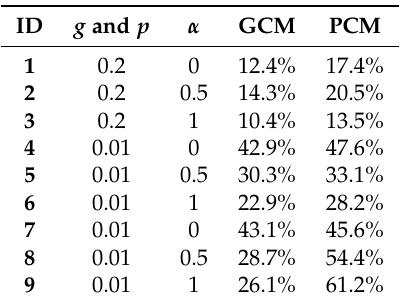
Table 1. Simulation experiments. Legend: ID is the experiment identifier; g , p refer to the cell coverage thresholds; GCM is the global coverage metric; PCM is the people coverage